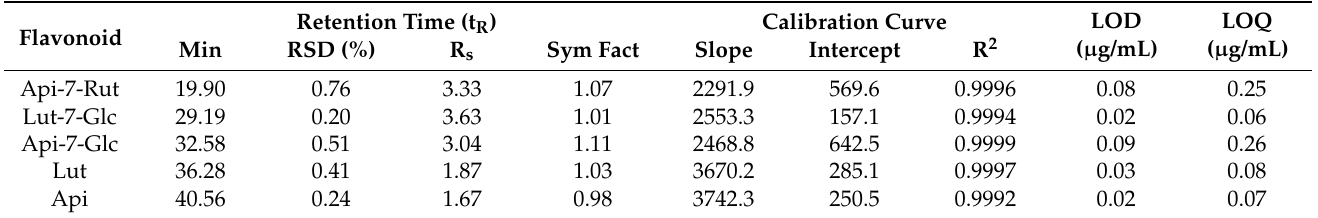
Table 2. Calibration function parameters for major flavonoids from M. angustifolia leaf extract using UV detection.